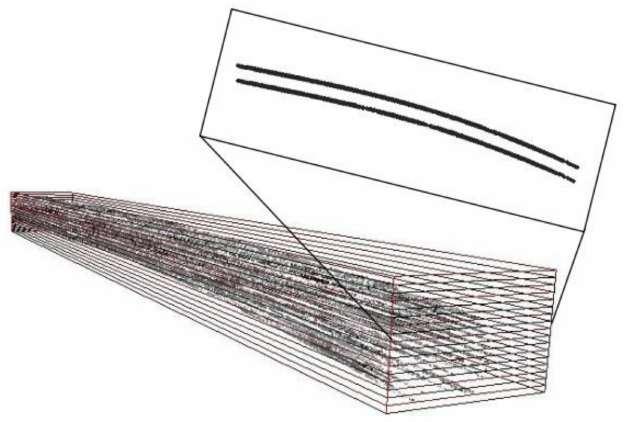
Figure 5. Point cloud section